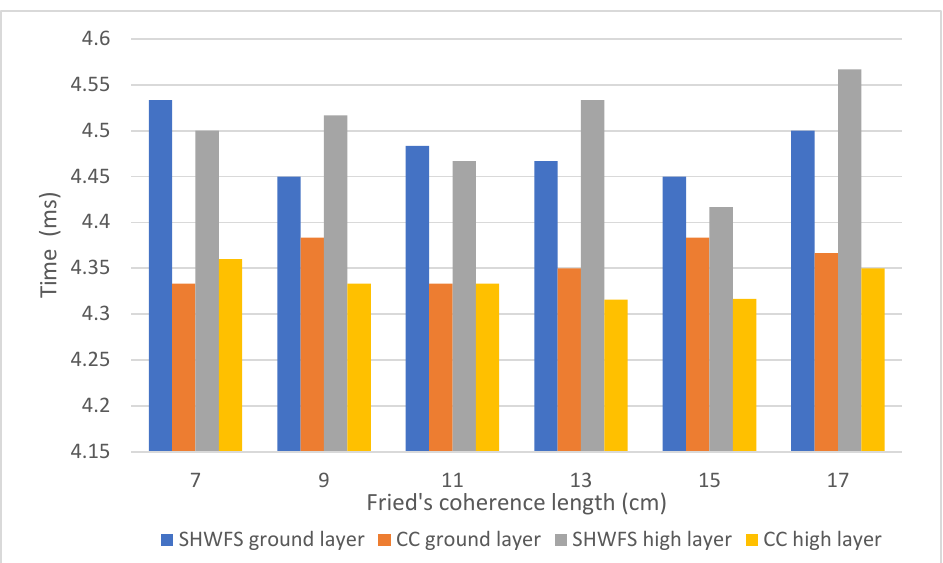
Figure 6. Required time needed per epoch for both models in the two cases of turbulence profiles considered. SHWFS represents the FCNs whose inputs are directly the information received by the wavefront sensor, while CC reconstruction corresponds to the cross-correlations. To make comprehension easier, the bars for each case are in the same order as the legend.